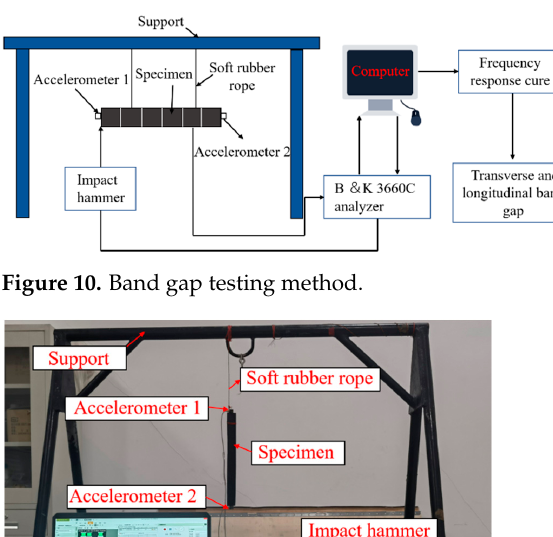
Figure 11. Free vibration testing platform.